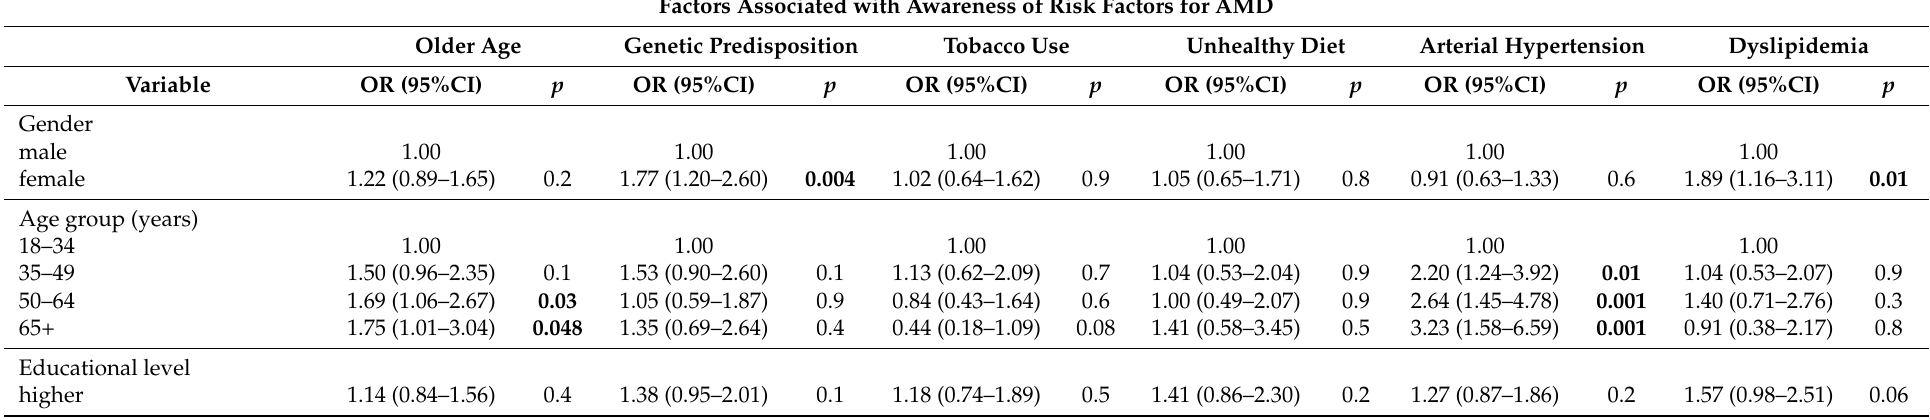
Table 8. Factors associated with awareness of risk factors for AMD (n =